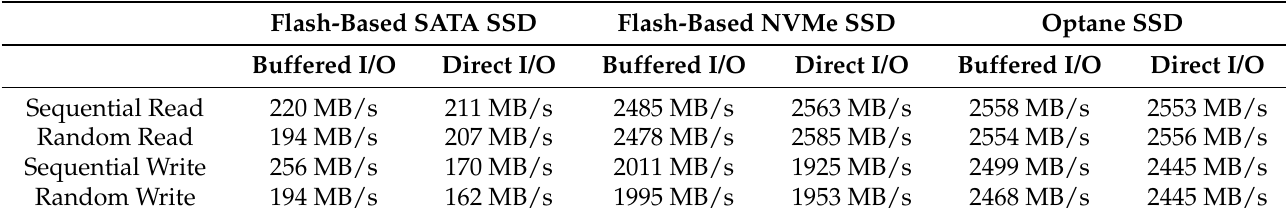
Table 1. Comparison among SATA SSDs, NVMe SSDs, and Optane